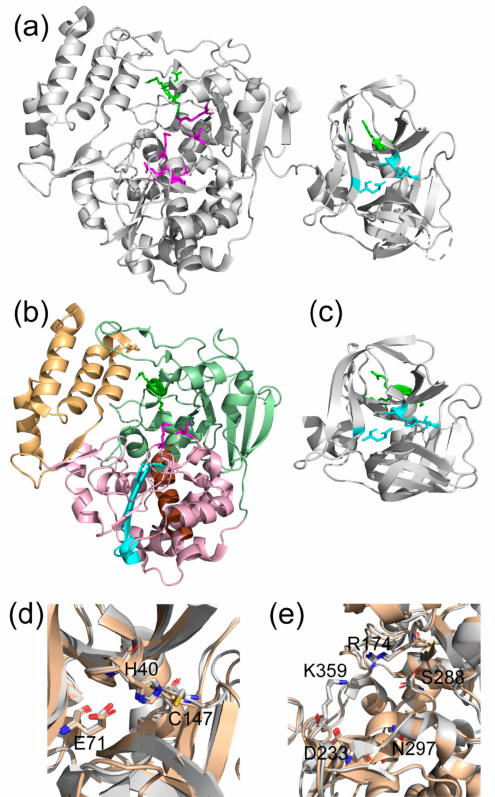
Figure 1. Structural comparison of poliovirus 3C, 3D, and 3CD proteins. ( a ) X-ray crystal structure of poliovirus 3CD (PDB: 2IJD). ( b ) X-ray crystal structure of poliovirus 3D RNA-dependent RNA polymerase (PDB: 1RA6). The subdomains of 3D are colored: palm – purple, fingers – green, thumb – orange. Motifs B and C in the palm subdomain are also colored, brown and cyan, respectively. ( c ) X-ray crystal structure of poliovirus 3C protease (PDB: 1L1N). The protease catalytic triad is shown in cyan, polymerase active site residues are shown in magenta, and RNA/PIP binding region is shown in green. ( d ) Active sites of 3C (gray) and 3C domain of 3CD (brown). ( e ) Active sites of 3D (gray) and 3D domain of 3CD